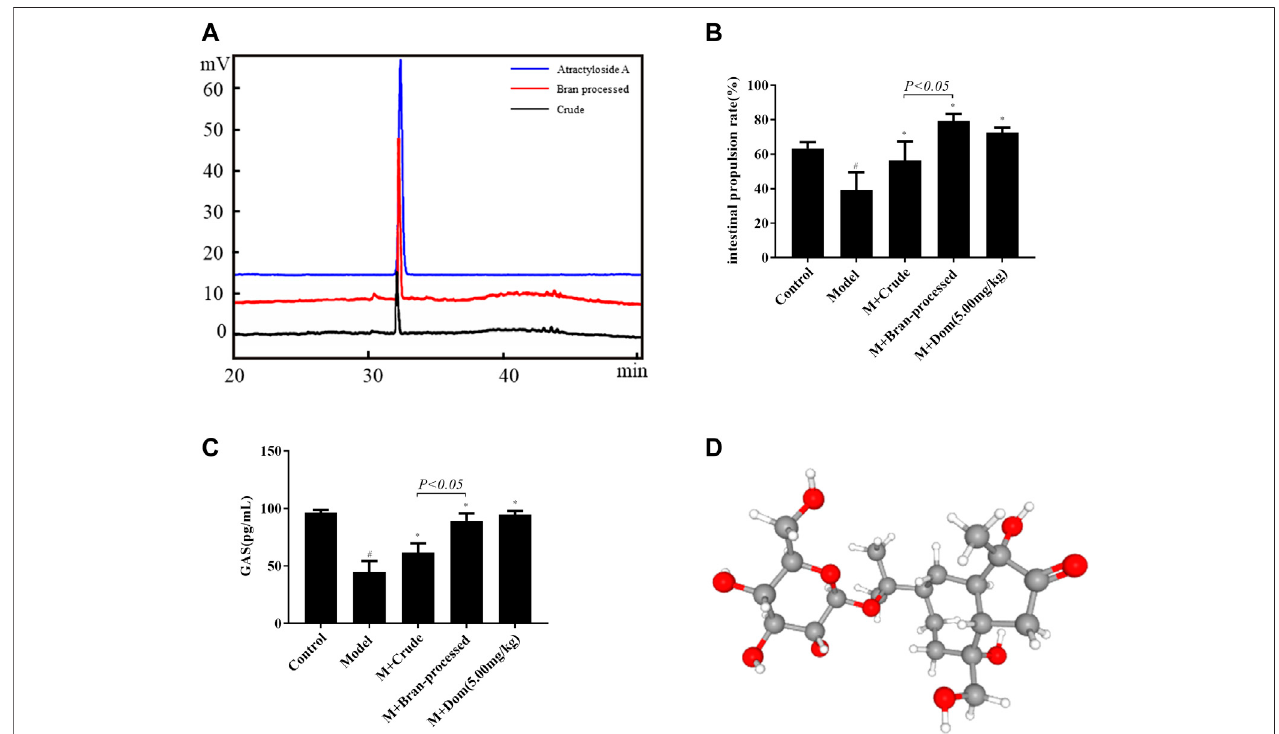
FIGURE 1 | Identi fi cation of AA as the active ingredient in crude and bran-processed Atractylodes lancea . Model: SDS model rats group; M + Crude: SDS model rats administrated with crudeAL extraction; M +Bran-processed: SDS model rats administrated with BAL extraction. (A) HPLC-ELSD chromatogramof the 50%EtOH extraction from AL (black) and BAL (red), the content of AA increased by 191.22% in the bran-processed Atractylodes lancea . (B) and (C) Comparison of the intestinal propulsion rate and GAS in SDS rats treated with crude and bran-processed Atractylodes lancea extracts. (D) 3D structure of AA. Data represented mean ± SD. Results are expressed as the mean ± SD from at least three independent experiments. * p < 0.05, compared with model; # p < 0.05, compared with control.